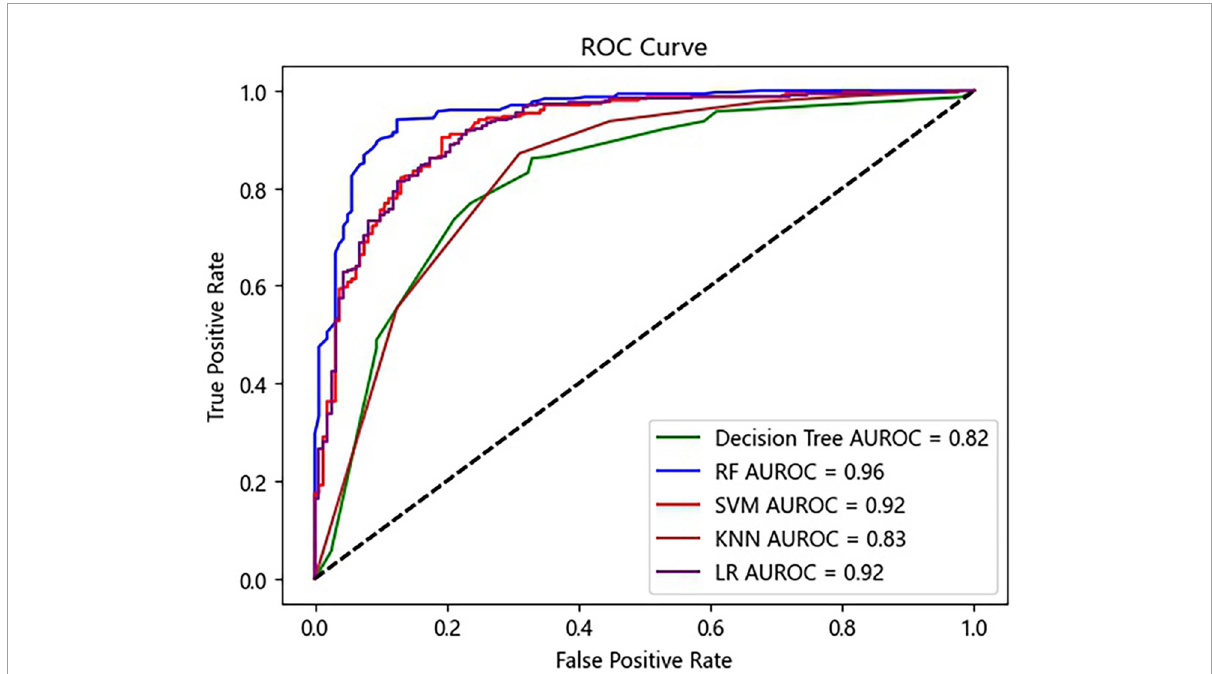
FIGURE3 Receiver operating characteristic (ROC) curves of the prediction model. RF, random forest; SVM, support vector machine; KNN, K-nearest neighbor; LR, logistic regression.